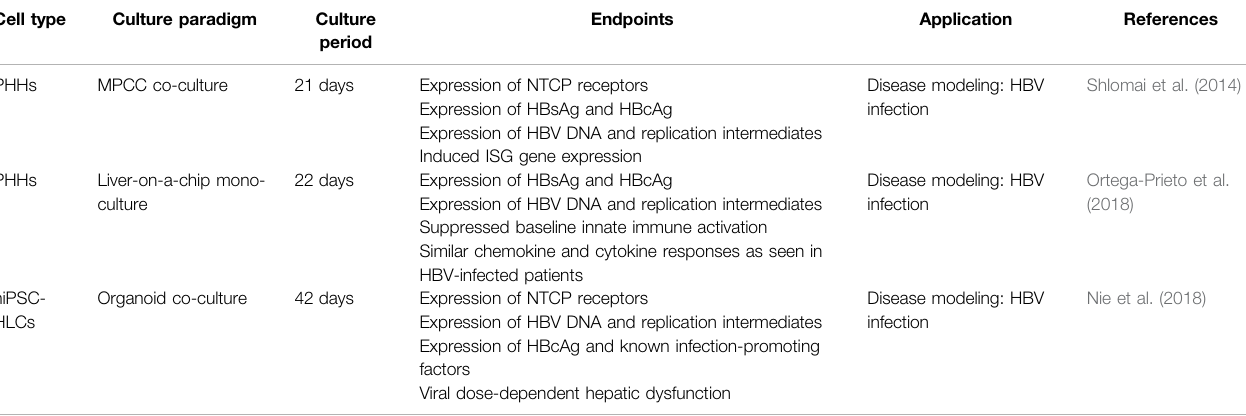
TABLE 4 | Selected 3D viral hepatitis models established from different cell